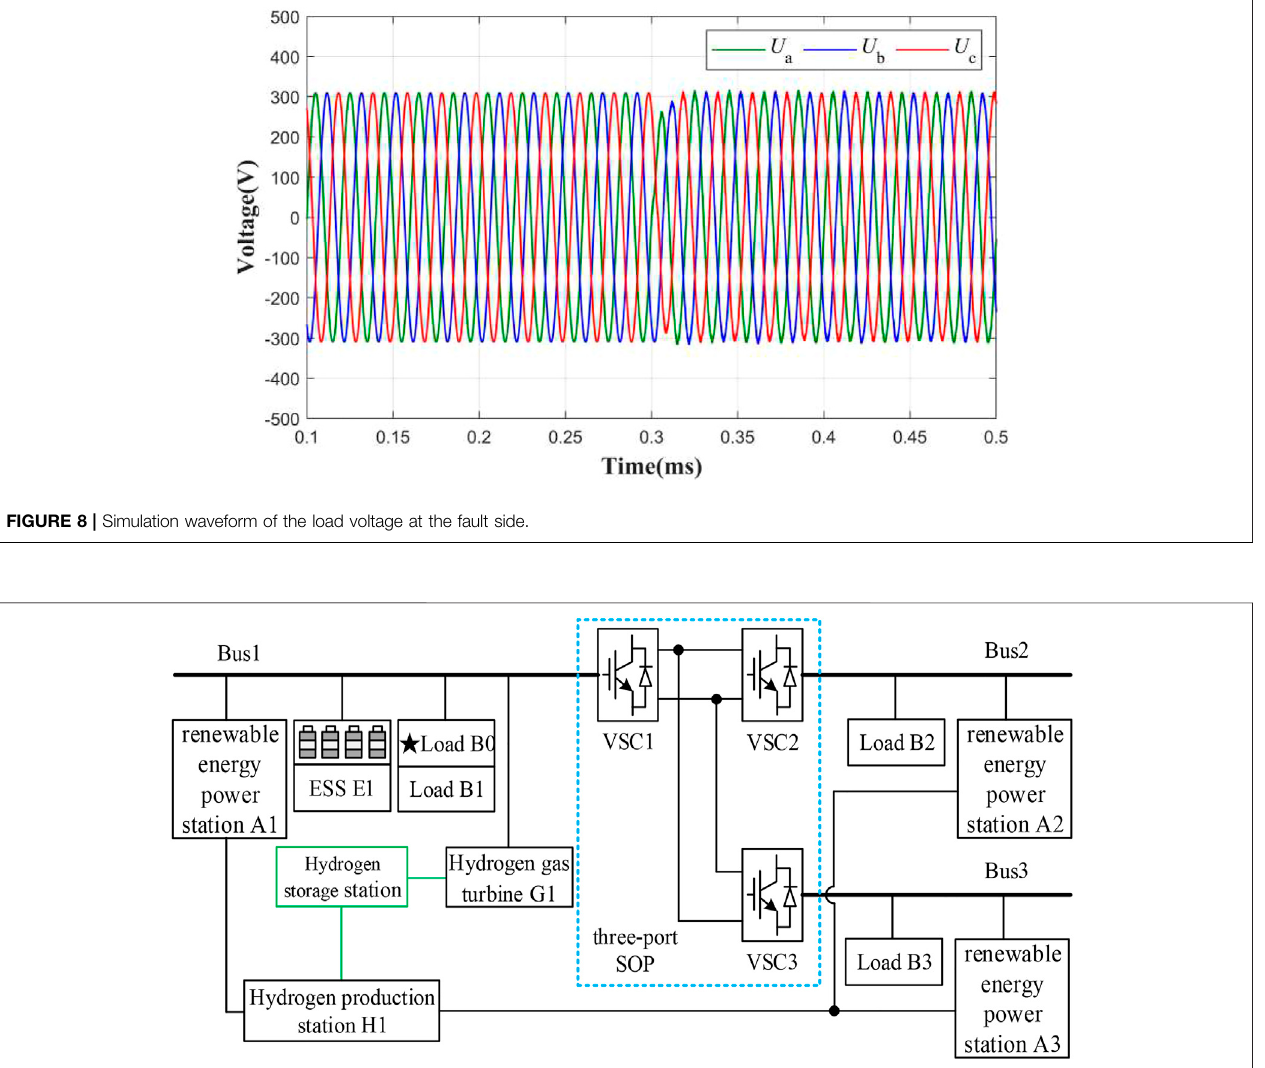
FIGURE 9 | Case of